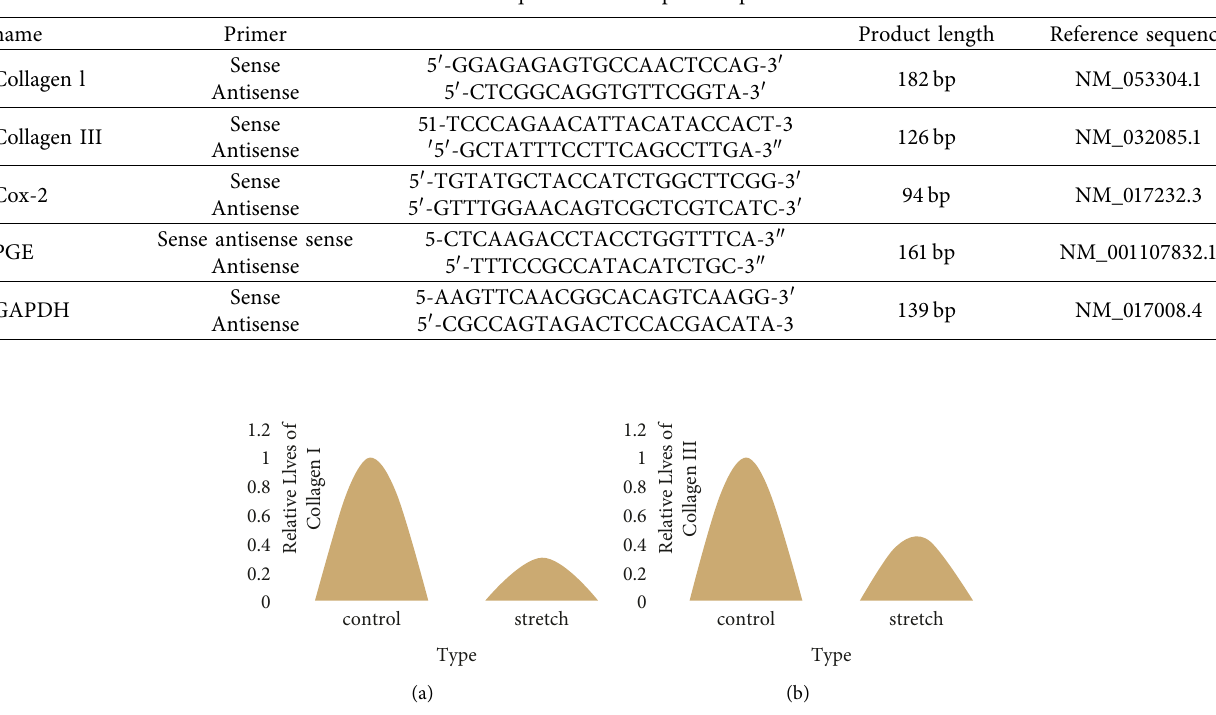
Figure 6: Effects of 10% strain and 1Hz mechanical stretching for 24 h on the expression of tenocyte-related genes in rats. (a) Relative longevity of type I collagen. (b) Relative longevity of type III collagen.